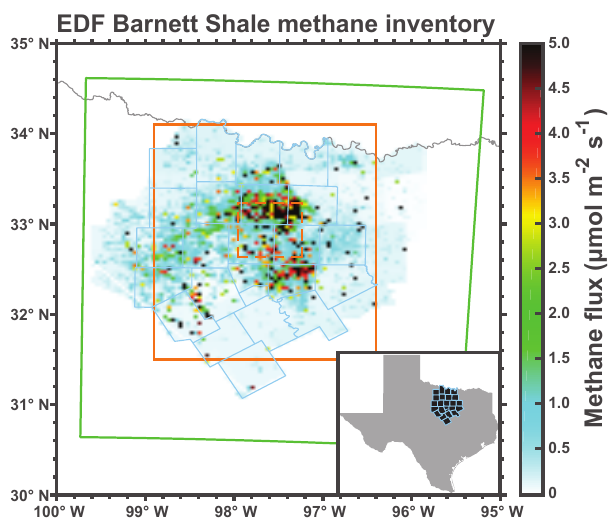
Figure 3. Gridded Environmental Defense Fund (EDF) methane emission inventory for the Barnett Shale in Texas in October 2013 (Lyon et al., 2015). Spatial resolution is 4 × 4km 2 . White ar- eas are outside the inventory domain.